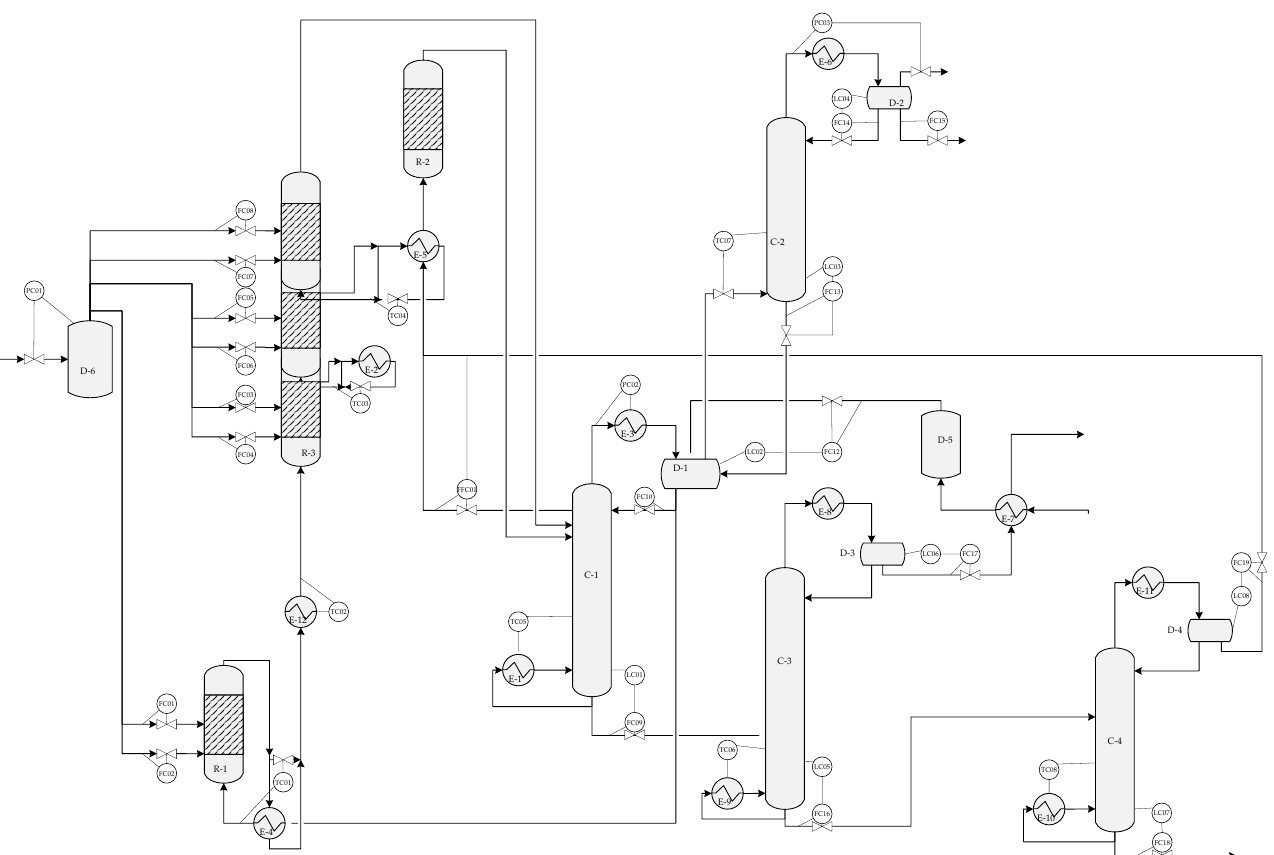
a − 1 ethylbenzene process flowsheet diagram. Figure 4. The 500 kt ·